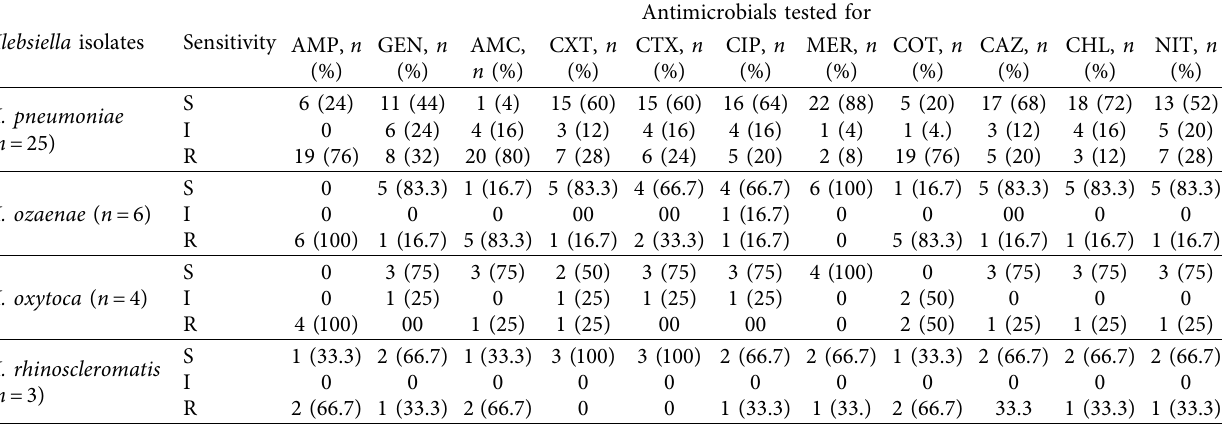
Table 2: Antimicrobial resistance patterns of Klebsiella species isolated from UTI-suspected patients who attended Bahir Dar City health institutions, Bahir Dar, Northwest Ethiopia, 2019. Klebsiella isolates